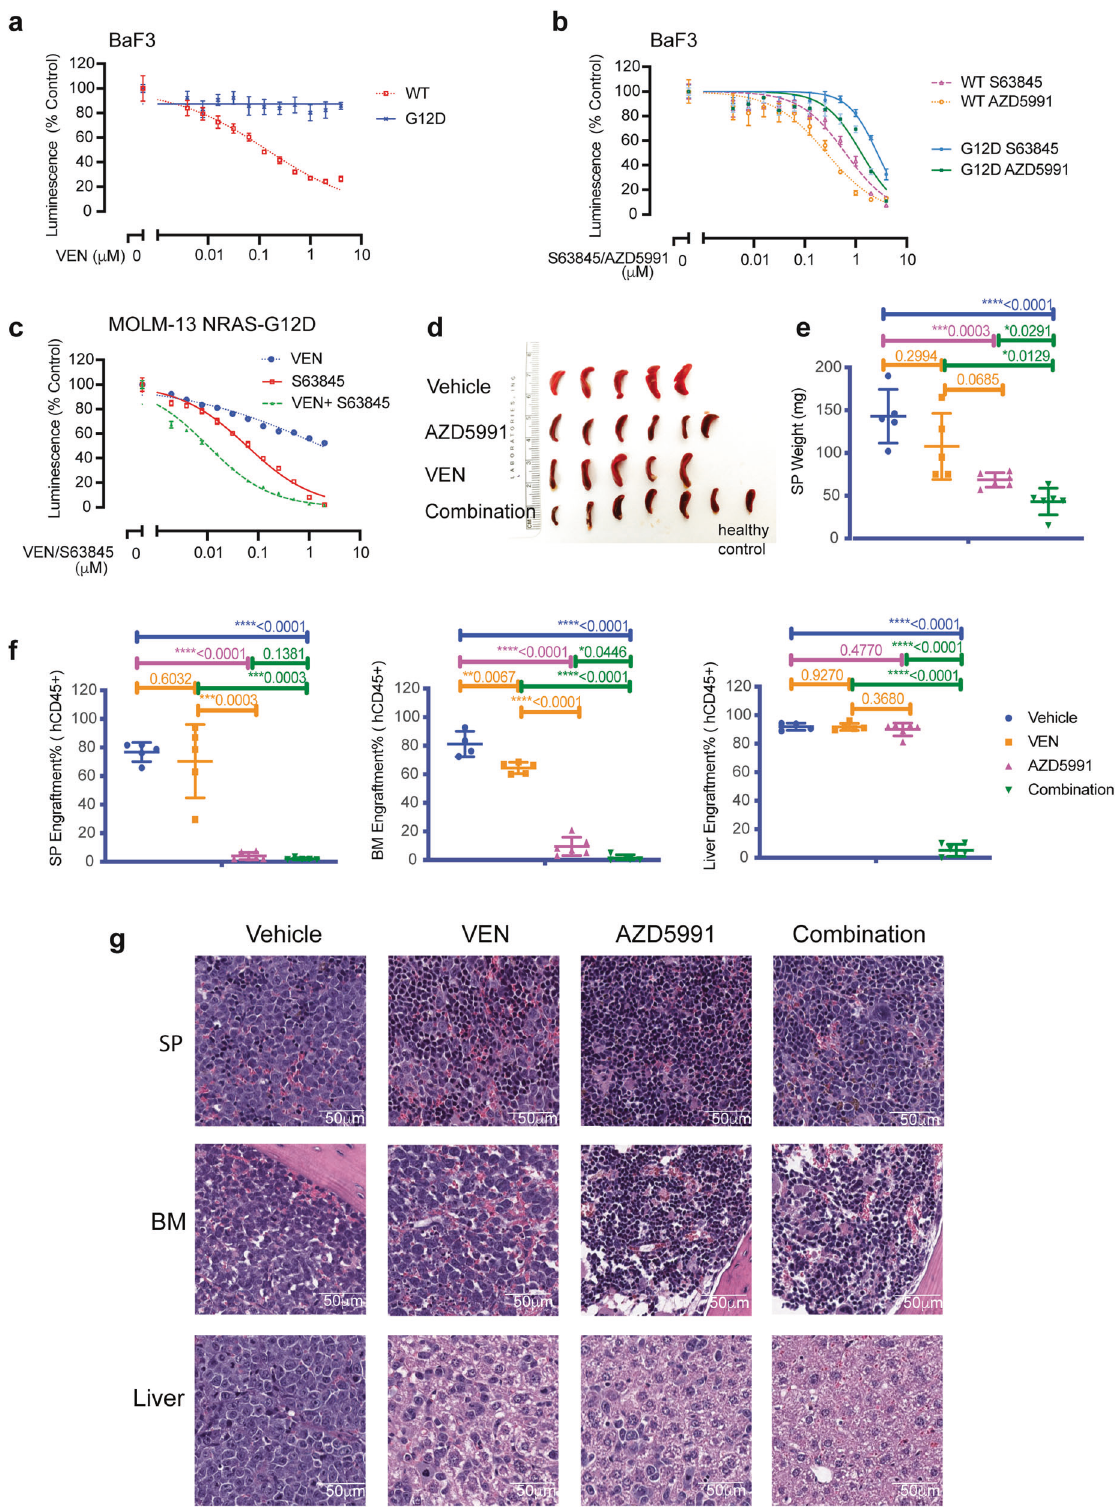
combinatorial therapy already empirically adapted in AML clinical